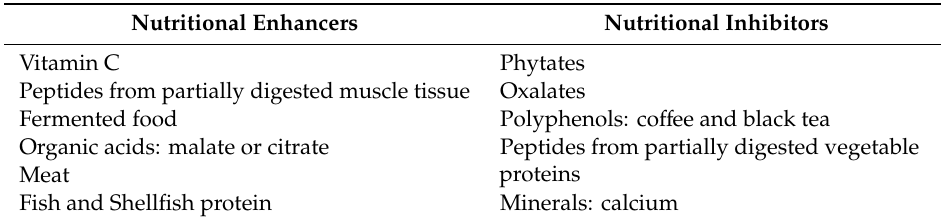
Table 1. Nutritional Enhancers and Inhibitors of Iron